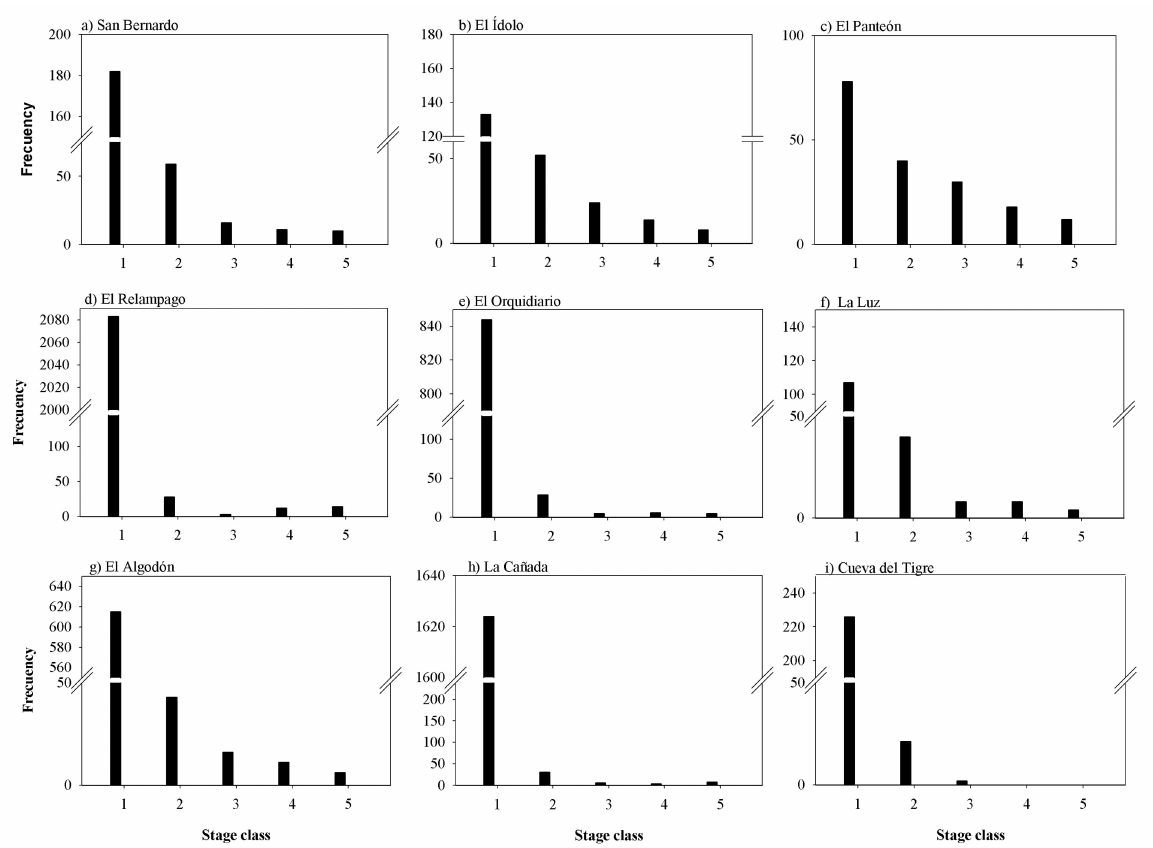
Figure 3. Frequency distributions in O. mexicana according to stage class, expressed as abundance of individuals for each population: ( a ) San Bernando; ( b ) El Í dolo; ( c ) El Pante ó n; ( d ) El Relampago; ( e ) El Orquidiario; ( f ) La Luz; ( g ) El Algod ó n; ( h ) La Cañada and ( i ) Cueva del Tigre. The spatial distribution pattern of O. mexicana showed dependence on the scale of